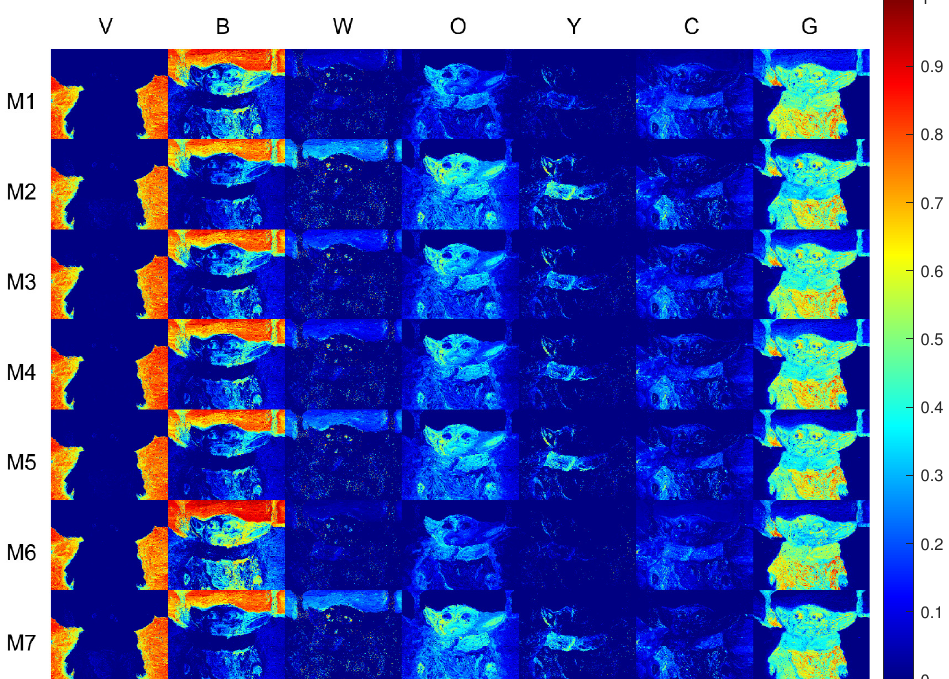
Figure 10. Pseudo-colour concentration maps related to each pigment (by column ) and investigated imaging models (by row ). The best performances are obtained by the subtractive-based models, whereas the additive-based models reported the poorest